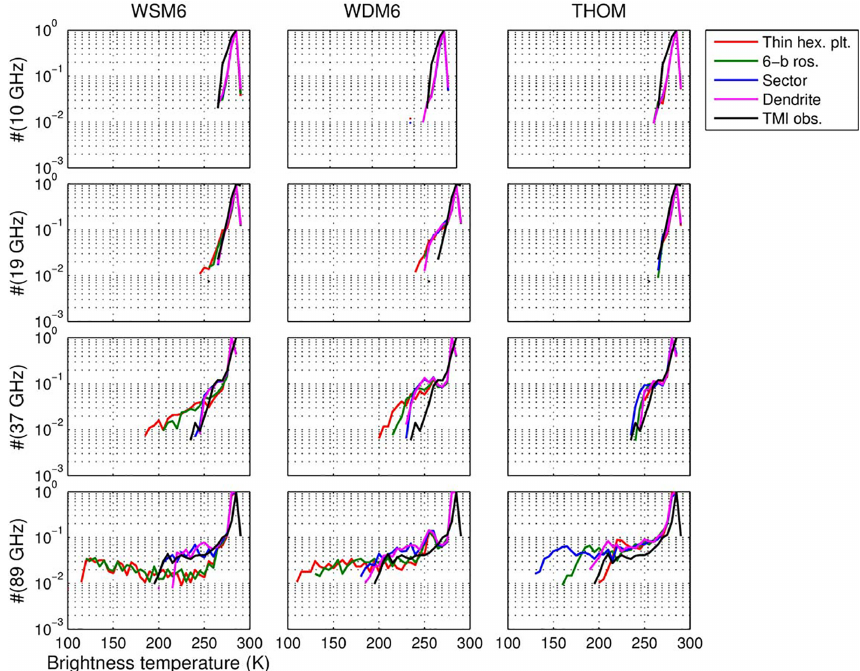
Figure 10. The observed (solid black line) and simulated (solid coloured lines) TMI brightness temperature distributions (built with 5K bins and where bins with less than five values are